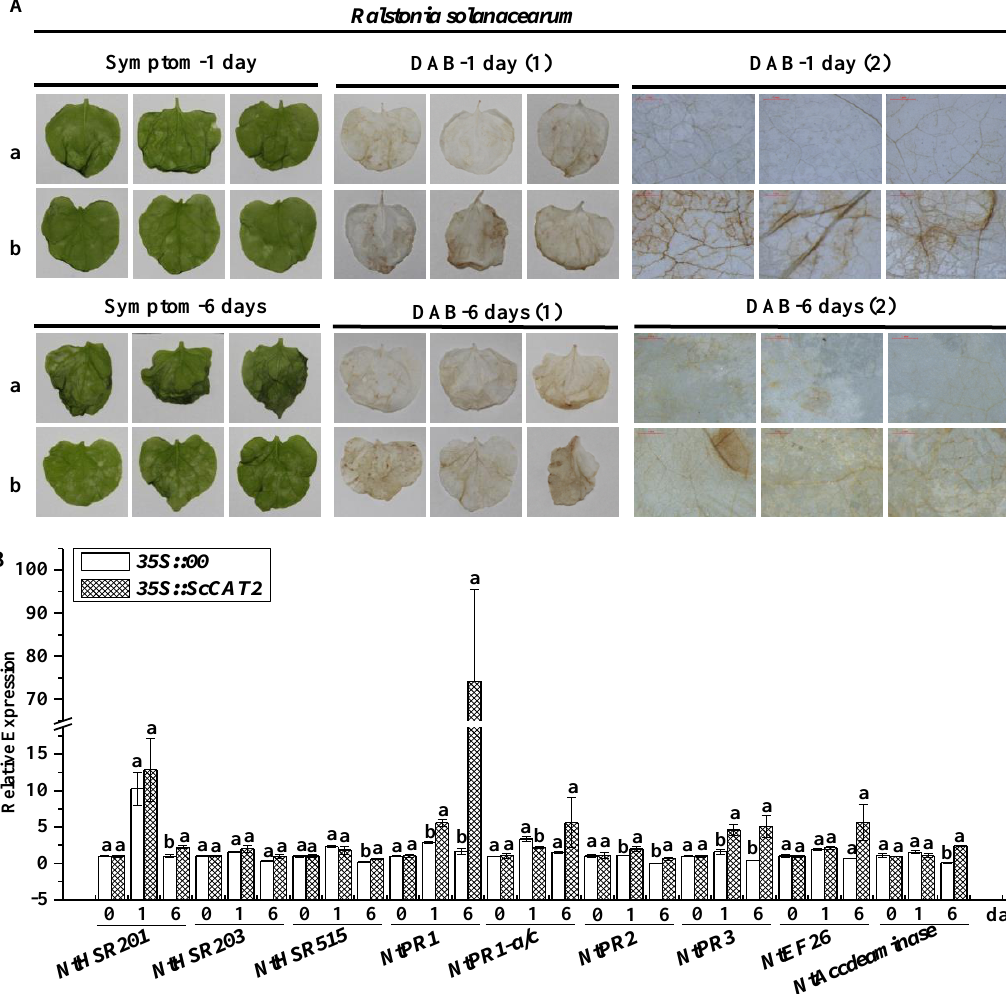
Figure 10. The effect of transient overexpression of ScCAT2 in Nicotiana benthamiana leaves after inoculation with Ralstonia solanacearum . ( A ) The disease symptoms and DAB staining of N. benthamiana leaves at 1 day and 6 days post-inoculation with R. solanacearum . ( B ) Analysis of nine tobacco immune-related marker genes in the N. benthamiana leaves 1 day and 6 days after inoculation with R. solanacearum . The tobacco immune-related marker genes, which included the hypersensitive response marker genes NtHSR201 , NtHSR203 , and NtHSR515 ; the salicylic acid-related genes NtPR-1 and NtPR-1a/c ; the jasmonic acid pathway-associated genes NtPR2 and NtPR3 ; and the ethylene synthesis-dependent genes NtEFE26 and NtAccdeaminase , and using NtEF1- α for data normalization. All data points were presented as means ± standard error ( n = 3). Different lowercase letters indicated a significant difference, as determined with Duncan’s test ( p < 0.05). The empty vector 35S::00 and recombinant vector 35S::ScCAT2 were indicated by a and b, respectively. (1) and (2) represented images captured using a SONY camera and microscope, respectively. Bar = 1 mm.